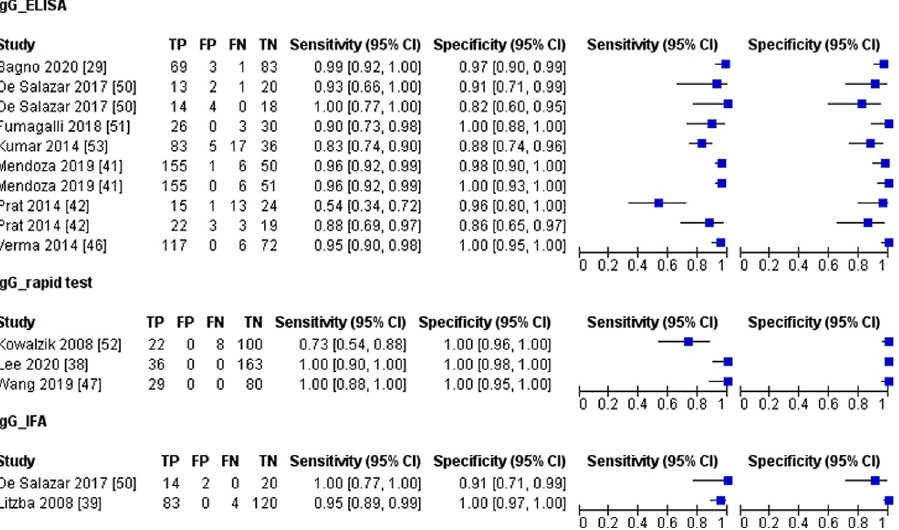
Fig 6. Forest plot for IgG detection test based on test format; CI, confidence interval; TP, true positive; FP, false positive; FN, false negative; TN, true negative.